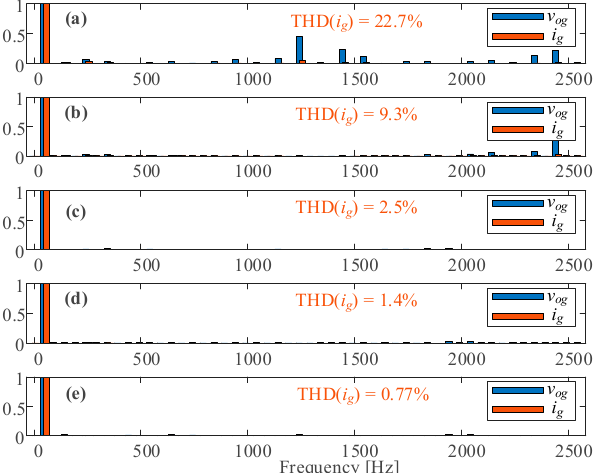
Figure 6. Normalized voltage and current response under different number of sampling per period